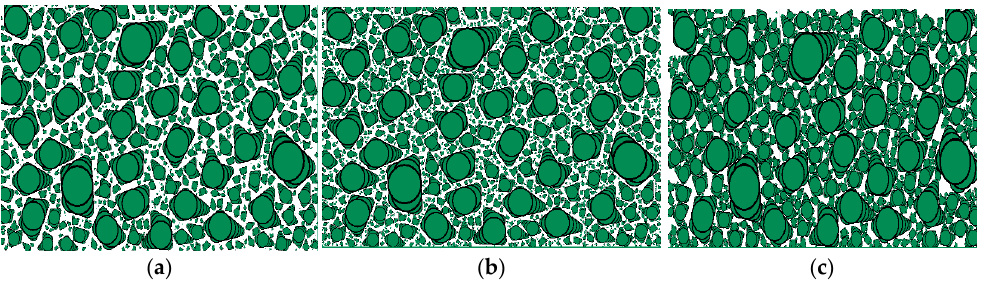
Figure 5. ( a ) Mixture model with porosity 25%. ( b ) Mixture model with porosity of 20% ( c )Mixture model with porosity of 10%.